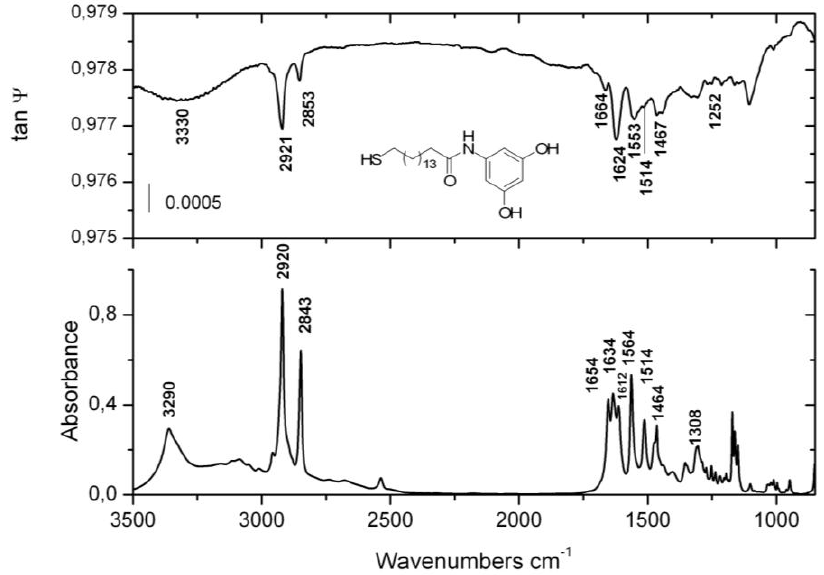
Figure 2. IR tan  ellipsometric spectrum (top) of 5b SAM on Au(111). The angle of incidence was 70  and the spectral resolution 4 cm −1 . ( Bottom) IR absorption spectrum of the bulk compound in KBr.